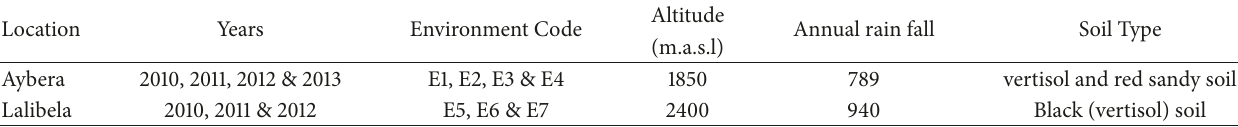
Table 1: Description of the test